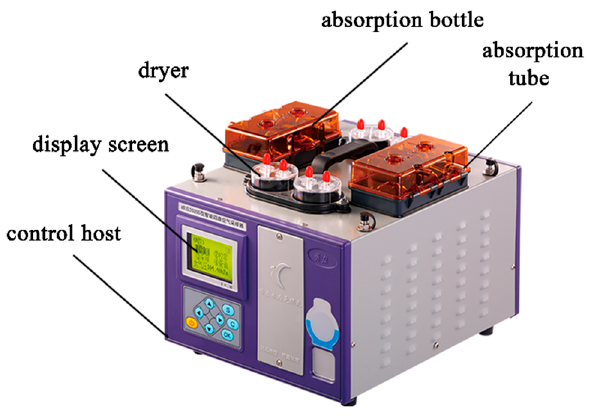
Figure 2. Two-channel air sampler.